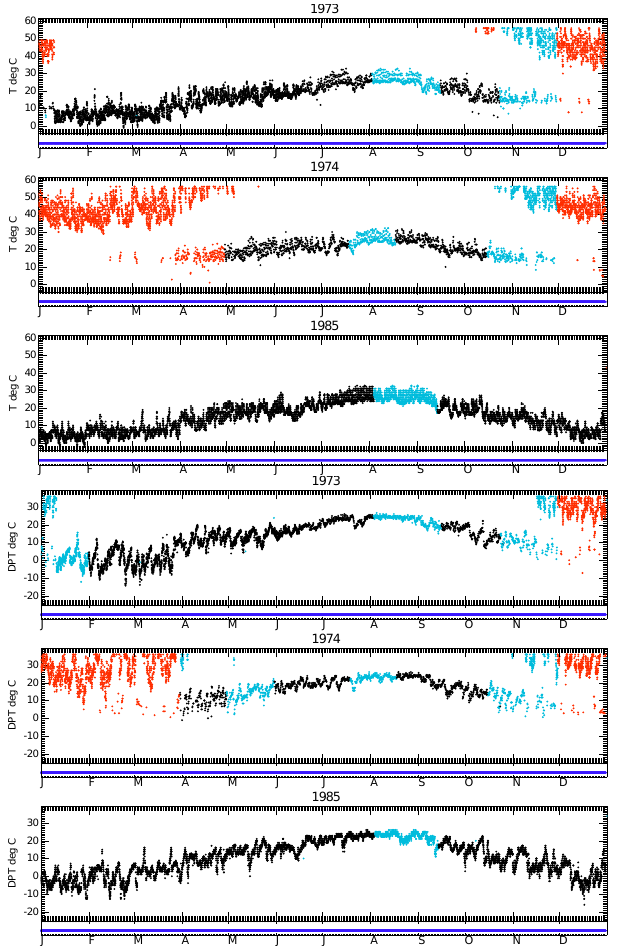
Fig. 7. Distributional gap check (test 6) example when comparing all of a given calendar month in the dataset for composite station 476960-43323, Yokosuka, Japan (35.58 ◦ N, 139.667 ◦ E, 530m), for (top) temperature and (middle) dewpoint temperature for the years 1973, 1974 and 1985. Red points show values removed by this test and blue points by other tests (in this case, mainly the diurnal cycle check). The problem for this station affects both variables, but the tests are applied separately. There is no change in source station in any of the years, and so compositing has not caused the bad data quality of this station.